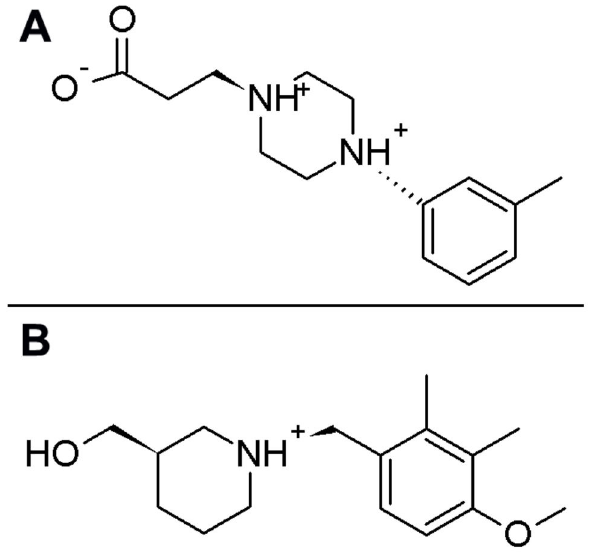
Figure 3. Two-dimensional structures of Fragment 1 and Fragment 8. Two-dimensional structures of Fragment 1 and 8 are shown in panels A and B, respectively.